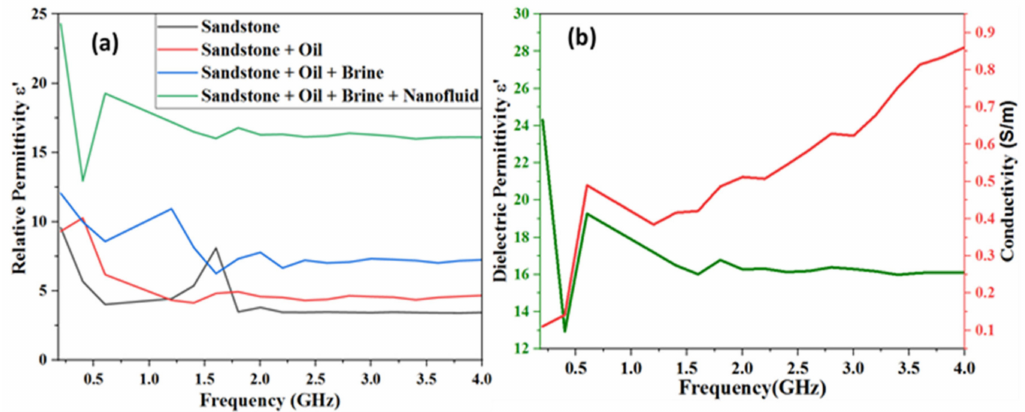
Figure 6. ( a ) Dielectric permittivity of the sandstone sample at di ff erent saturations and ( b ) permittivity and conductivity variation of the sample saturated with brine, oil and